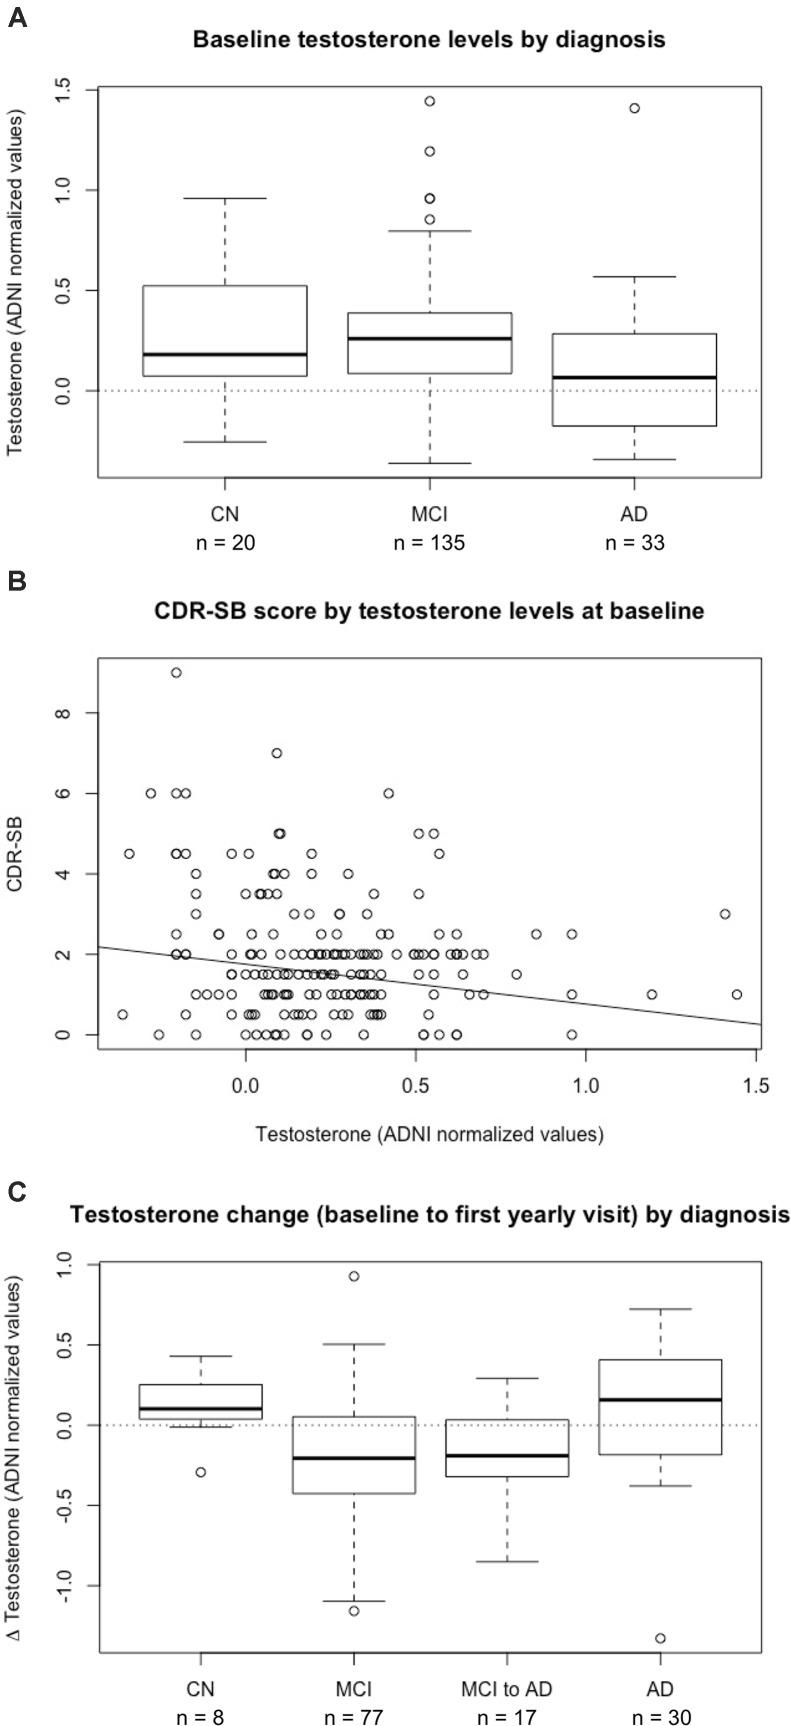
Plasma testosterone levels are associated with diagnosis and predict clinical disease severity in men. (A) Baseline plasma testosterone levels by diagnosis in 188 male participants in ADNI. There is a significant difference between diagnostic groups of CN (cognitively normal controls), MCI (mild cognitive impairment), and AD (Alzheimer’s disease) (p = 0.02), with post hoc pair-wise tests showing a significant difference in testosterone levels between MCI and AD (pAdjusted,BH = 0.015). (B) Baseline plasma testosterone levels are a significant negative predictor of clinical severity, as measured by CDR-SB (Clinical Dementia Rating Sum of Boxes) (β = –0.99 ± 0.35, p = 0.007). (C) Plasma testosterone changes from baseline to first annual visit by diagnosis in 132 male participants in ADNI. There is a significant difference between diagnosis groups of CN, MCI, MCI to AD conversion, and AD (p = 0.003). Post hoc pairwise tests show a significant difference between MCI and AD diagnosis groups (pAdjusted,BH = 0.006). BH, Benjamini–Hochberg.